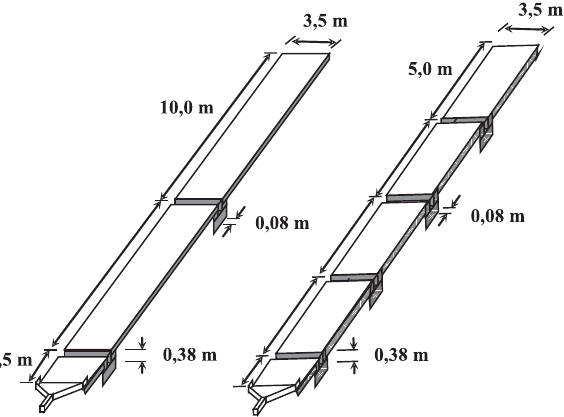
Figura 1. Esquema das parcelas experimentais e dos tratamentos com sulcos de vertical mulching